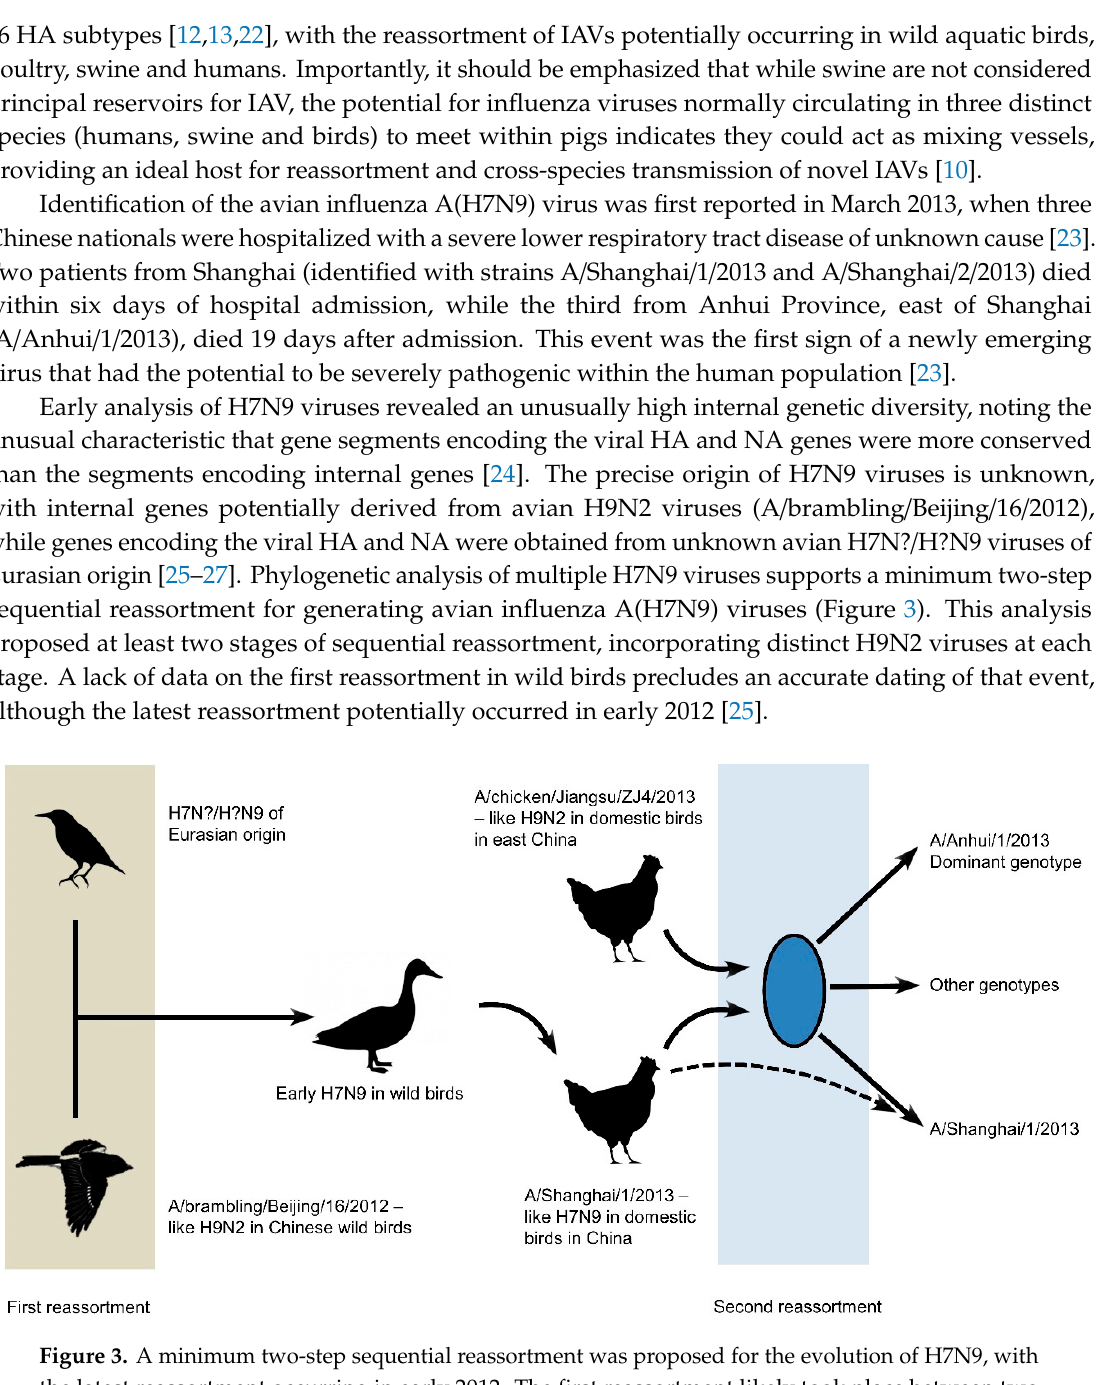
Figure 3. A minimum two-step sequential reassortment was proposed for the evolution of